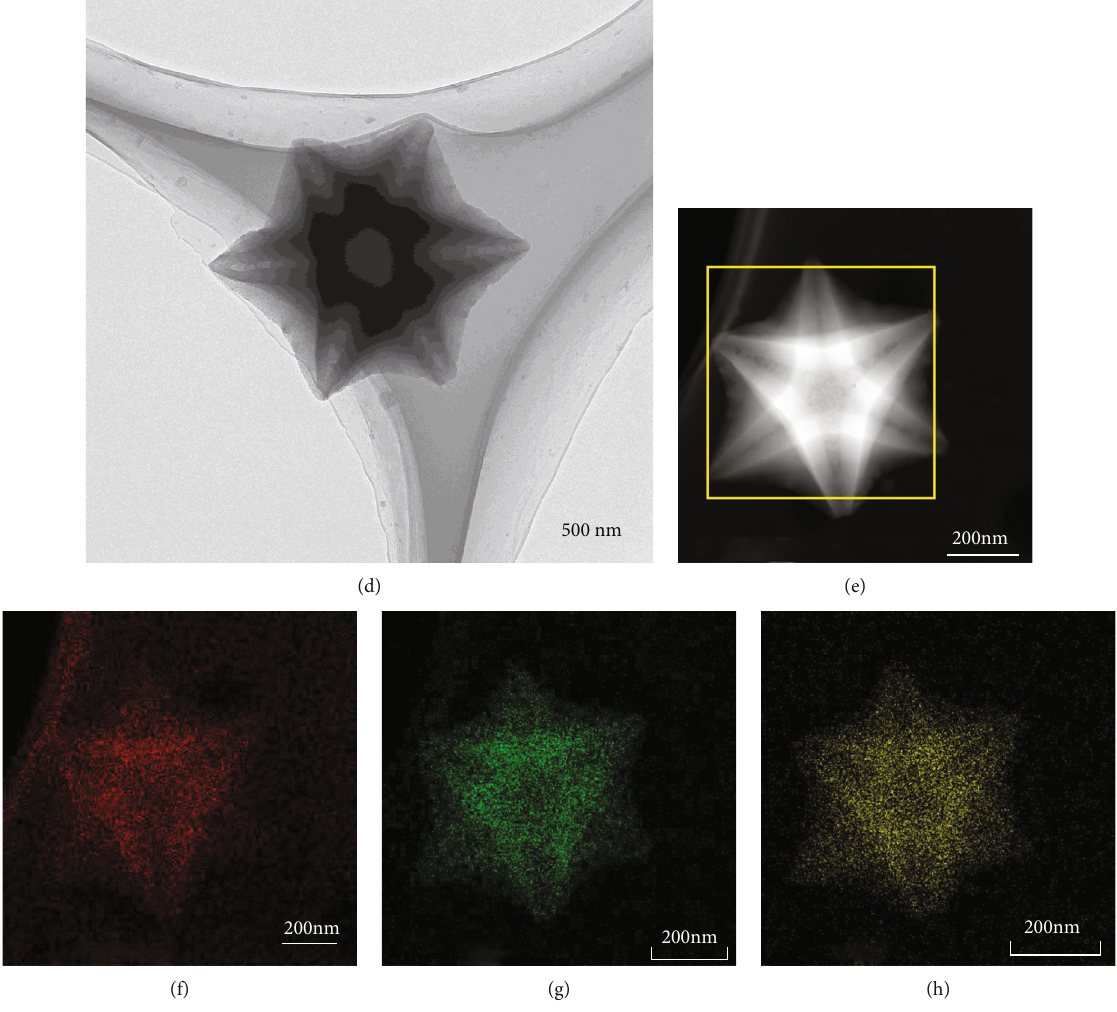
Figure 1: (a, b) SEM images of MIL-53 (Fe). (c, d) TEM images of MIL-53 (Fe). (e – h) Elemental mapping of MIL-53